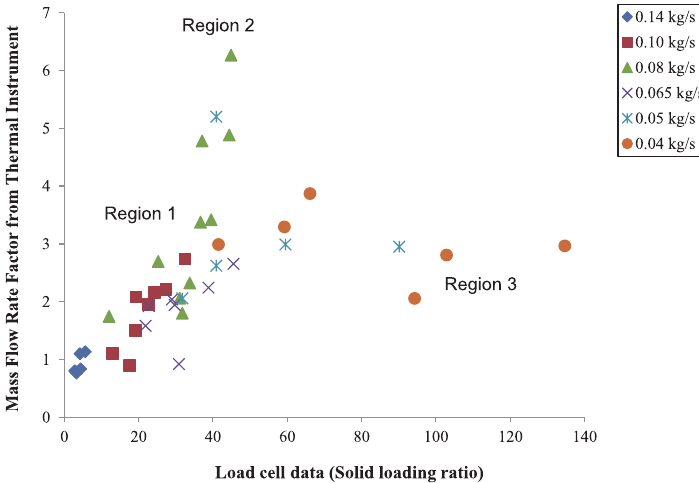
Fig. 4 Results obtained for the mass flow rates of solids using the thermal instrument. The legend shows the different air mass flow rates